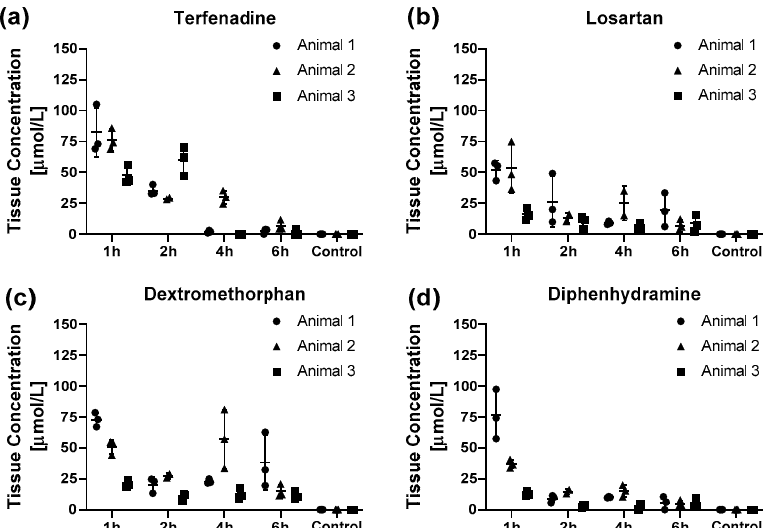
Figure 3. Pharmacokinetic profiles of the drug tissue concentrations for ( a ) terfenadine, ( b ) losartan, ( c ) dextromethorphan and ( d ) diphenhydramine for the different time points post-dosing obtained by LC-MS/MS analysis. The data is presented as individual marker for the technical replicates and mean ± SD of the animal. As the sample collection was terminal, animals 1–3 represent three different animals for each timepoint except for animal 2, 2 h post dose as one of the specimens was lost during the extraction process. One specimen from Animal 2, 4 h post dose was excluded as it exceeded the upper limit of the calibration range.